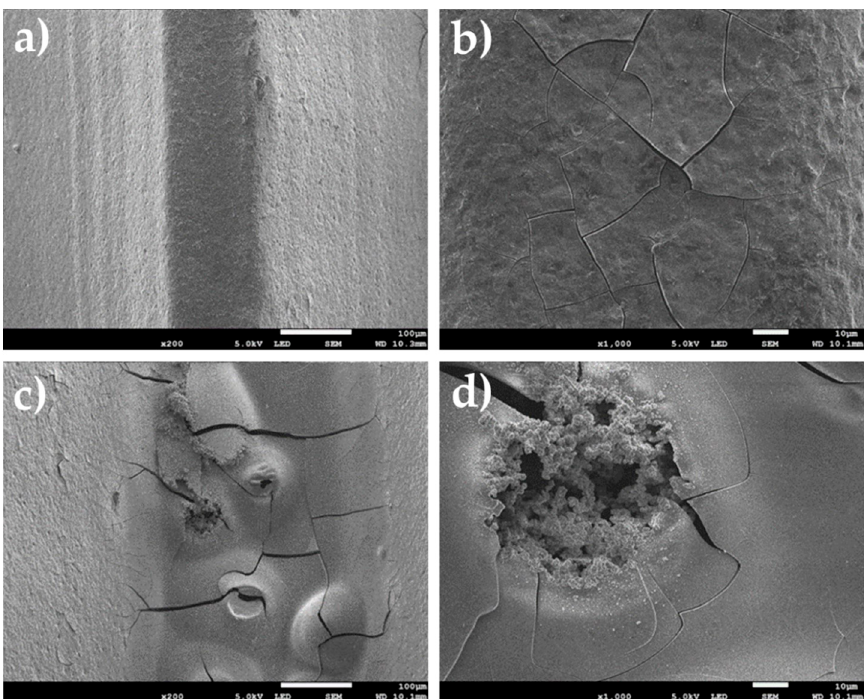
Figure 7. Surfaces of specimens oxidized in an electrochemical way after corrosion tests: ( a ) surface of helix top ×200, ( b ) surface of helix top ×1000, ( c ) bottom of the helix ×200, ( d ) bottom of the helix ×1000.